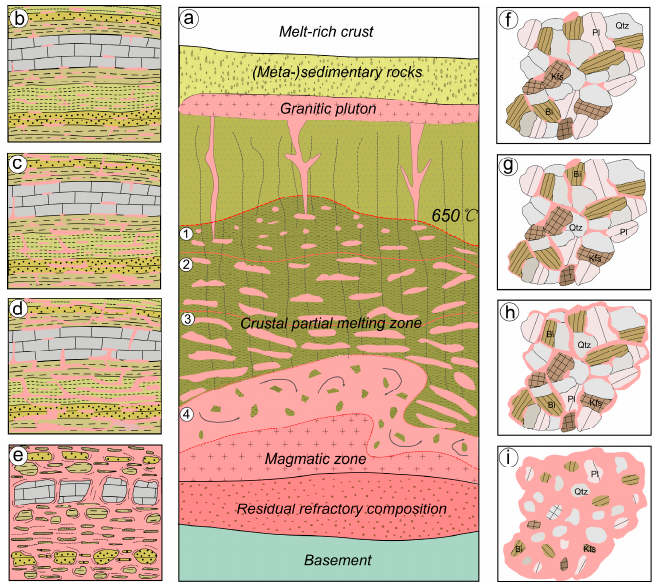
Figure 12. Model of the evolution of the “mixture” composed of partially molten rocks and melt in the Fuhuling during partial melting. ( a ) Partial melting zones of melt-rich crust. Four crustal partial melting zones correspond to the melt fractions of 0–7 vol.%, 7–21 vol.%, 21–40 vol.%, and > 40 vol.%. Metatexite formed in crustal zones (1)–(3), while diatexite formed in crustal zone (4), and as the partial melting proceeds, granite will eventually form. The 650 °C isotherm approximates the wet solidus of crustal rocks. ( b – e ) Macrostructural sketches of the “mixture” composed of partiallymolten rocks and melt, illustrating the rheological transitions due to changesin the melt fraction when going through the processes of melt production, melt segregation, melt migration, and melt redistribution, which correspond to the melt fractions of 0–7 vol.%, 7–21 vol.%, 21–40 vol.%, and > 40 vol.%, respectively (pink = melt, gray or yellow blocks = (meta)sedimentary rocks) (modified after [11,24]). ( f – i ) Microstructural sketches illustrating the evolution of the melt/solid two-phase system during partial melting corresponding to the melt fractions of 0–7 vol.%, 7–21 vol.%, 21–40 vol.%, and > 40 vol.%, respectively (pink = melt, Qtz = quartz; Kfs = K-feldspar; Pl = plagioclase; Bt = biotite).